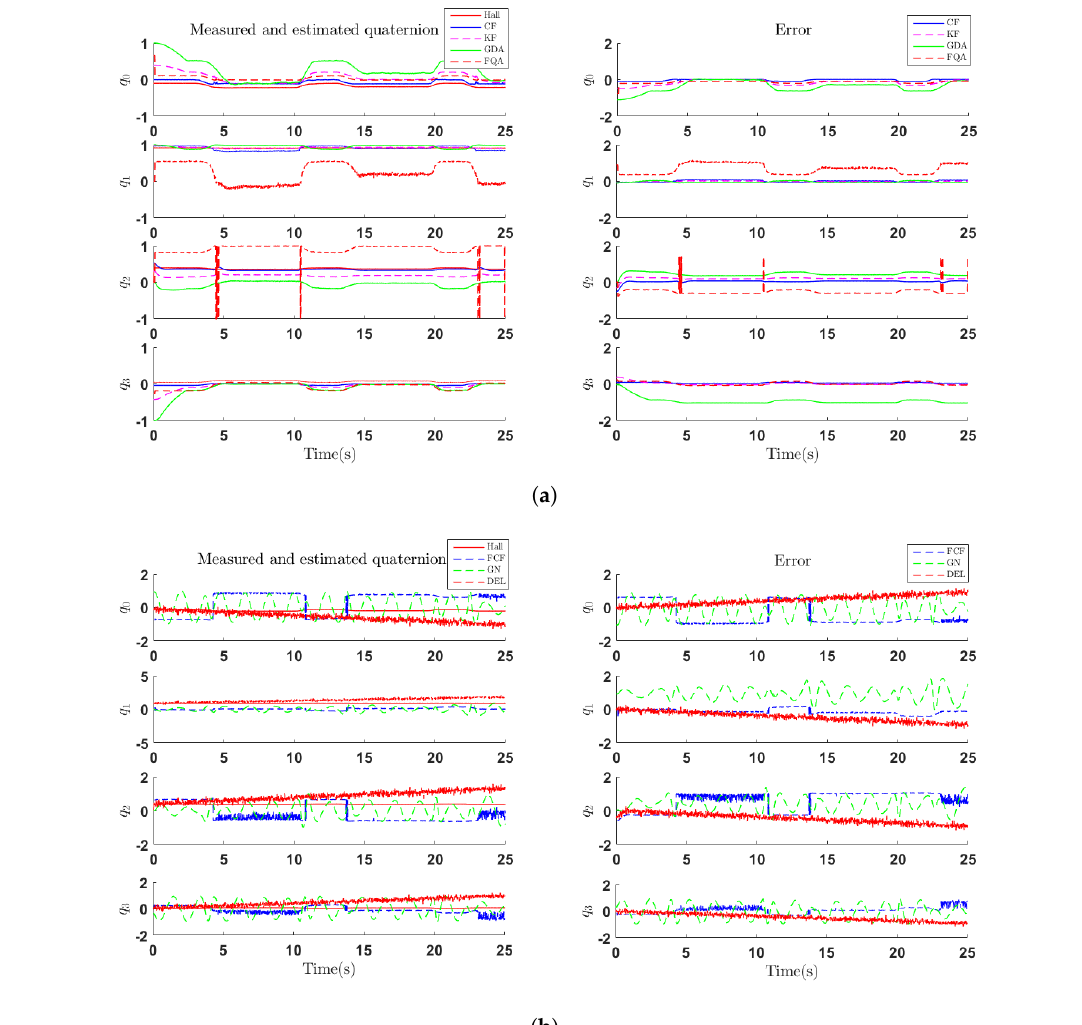
Figure 6. Measured and estimated quaternion (left) and error (right) of dynamic movement. ( a ) Comparison among quaternions estimated by CF, KF, GDA, FQA algorithms and reference quaternions obtained from Hall sensor. ( b ) Comparison among quaternions estimated by FCF, GN, DEL algorithms and reference quaternions obtained from Hall